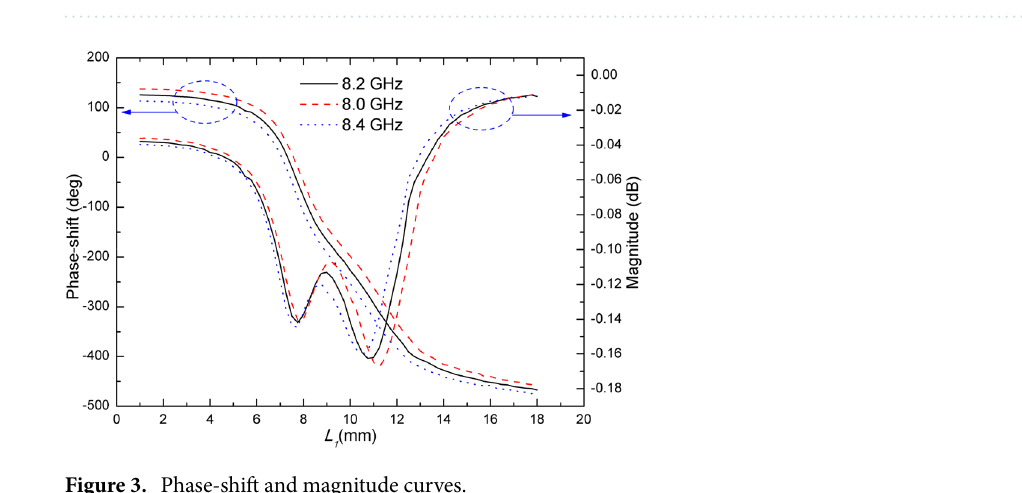
Figure 3. Phase-shift and magnitude curves.